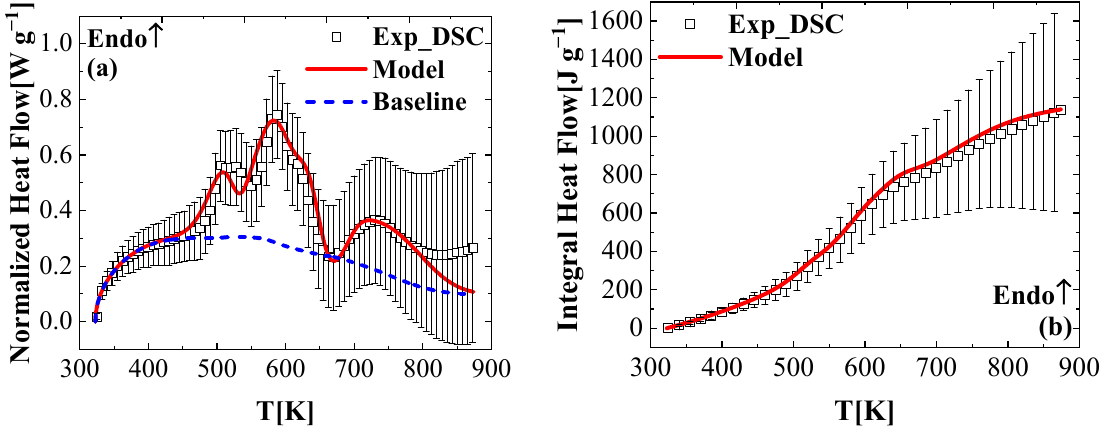
Figure 7. Experimental and simulated ( a ) normalized heat flows and ( b ) integral heat flow as a function of the temperature, obtained at a heating rate of 10 K min − 1 in nitrogen. The mean experimental normalized heat release rate (HRR) and the total heat release (THR) data obtained for the FR_PU_aerogel are presented as a function of the sample tem- perature in Figure 8. The heat of the complete combustion, h c , of the gaseous components defined in the reaction mechanism (summarized in Table 4) were determined through